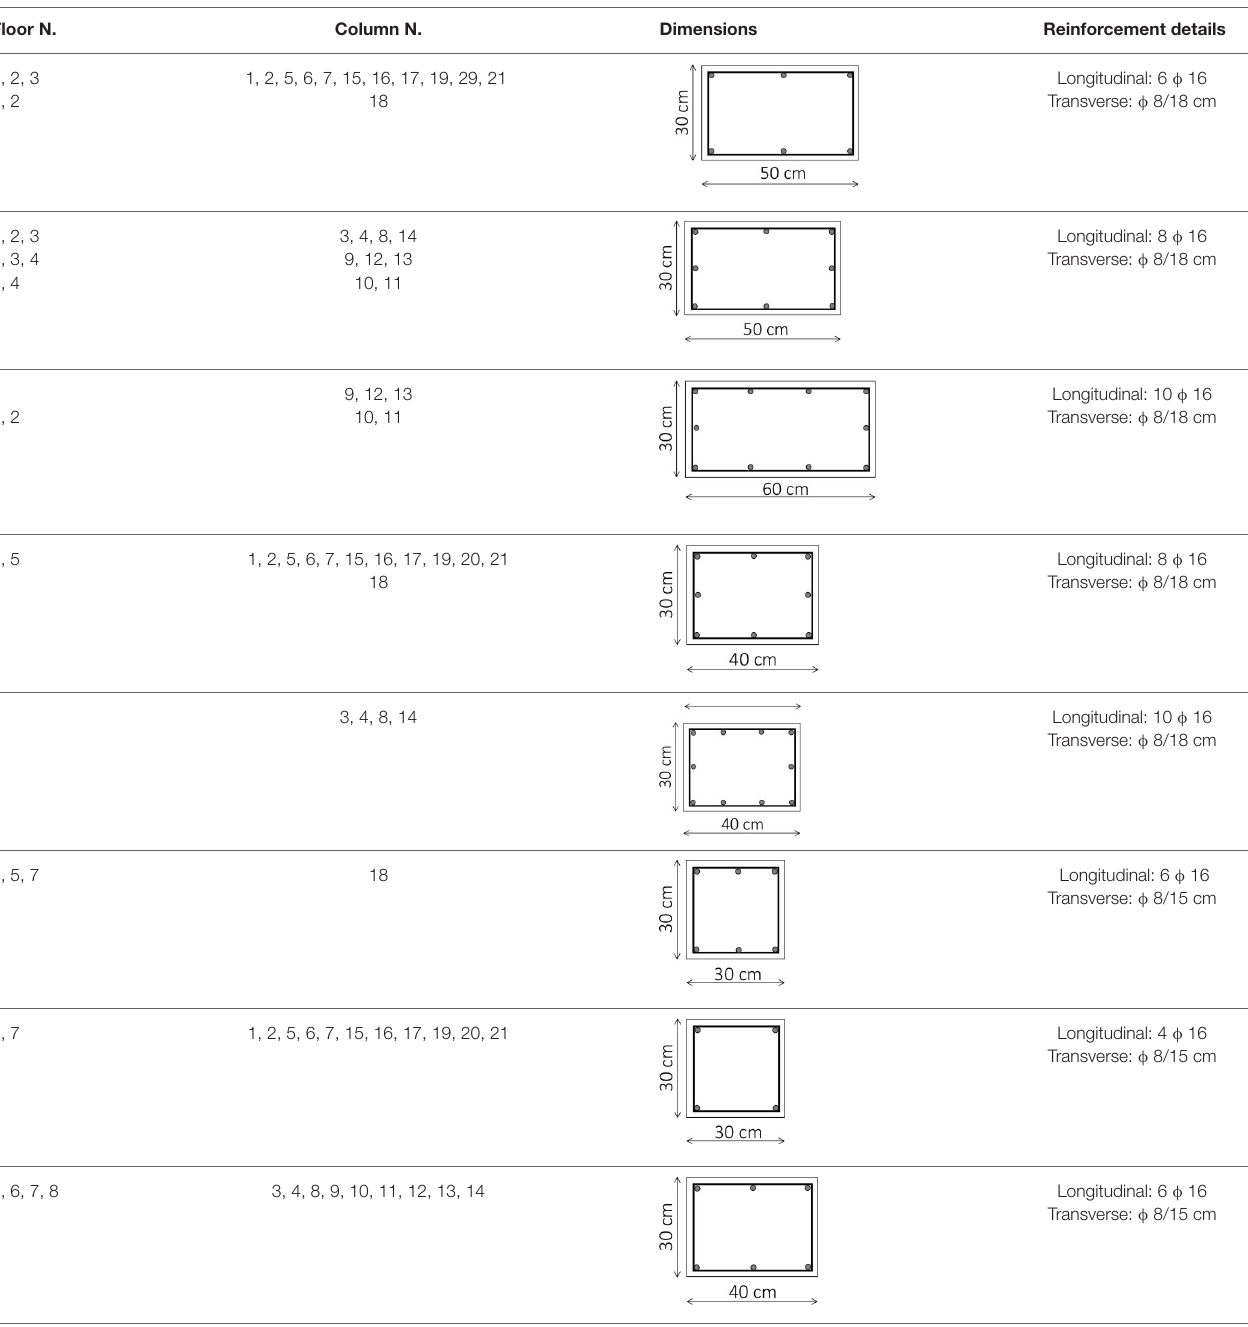
Longitudinal: 6 φ 16 Transverse: φ 8/15